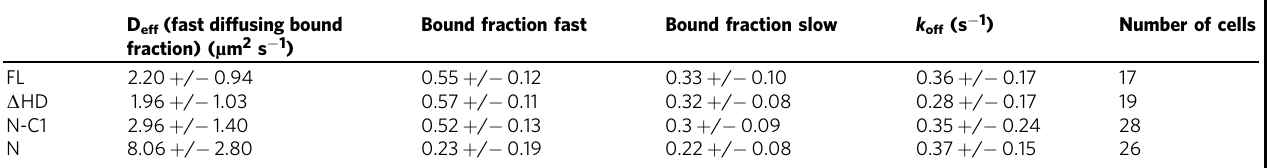
Table 2 Estimates of spatiotemporal FRAP fi t parameters for